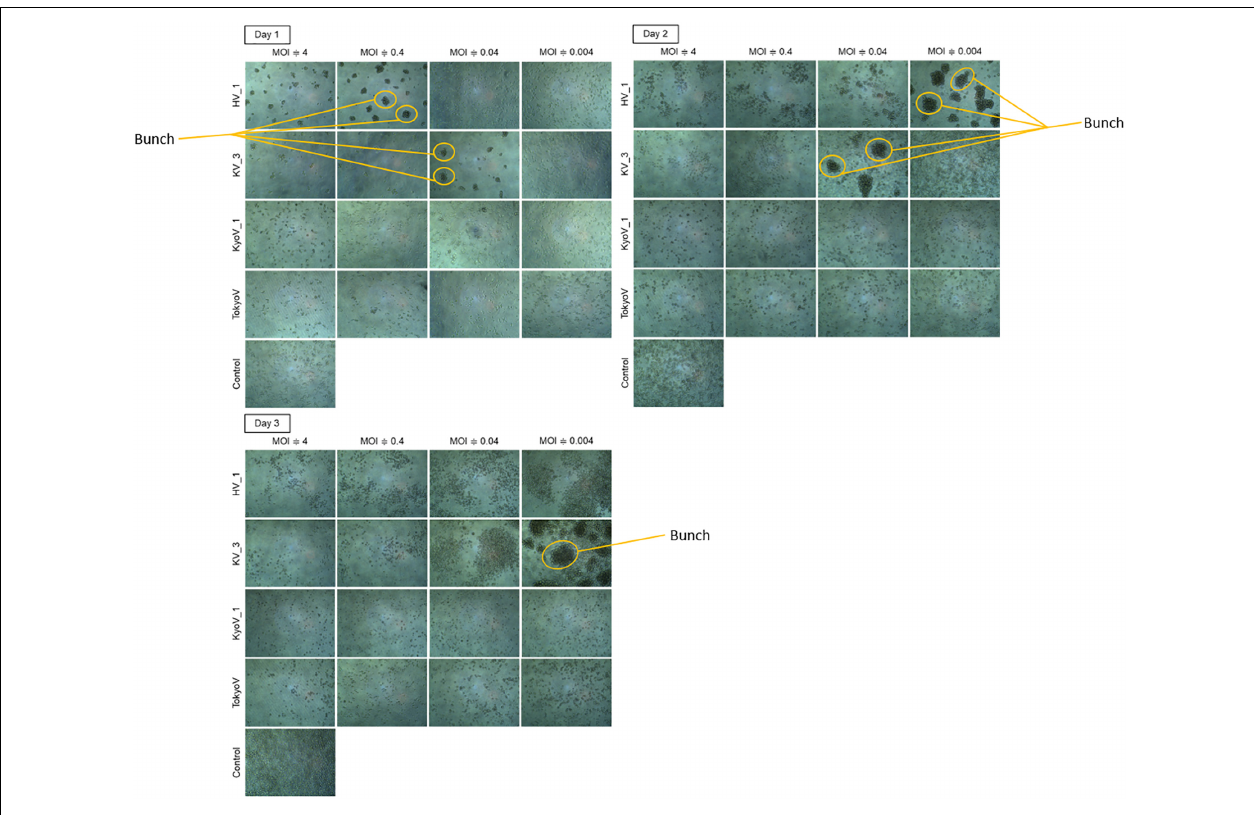
FIGURE 5 | “Bunch” formation of the amoeba cells. Hokutovirus (HV) 1, kashiwazakivirus (KV) 3, kyotovirus (KyoV) 1, and tokyovirus (TokyoV) were inoculated into A. castellanii cells with four degrees of titers (MOIs are approximately 4, 0.4, 0.04, and 0.004 calculated using TCID 50 values and A. castellanii cell count). Control: non-infected A. castellanii cells. Formed “bunch” are indicated by orange